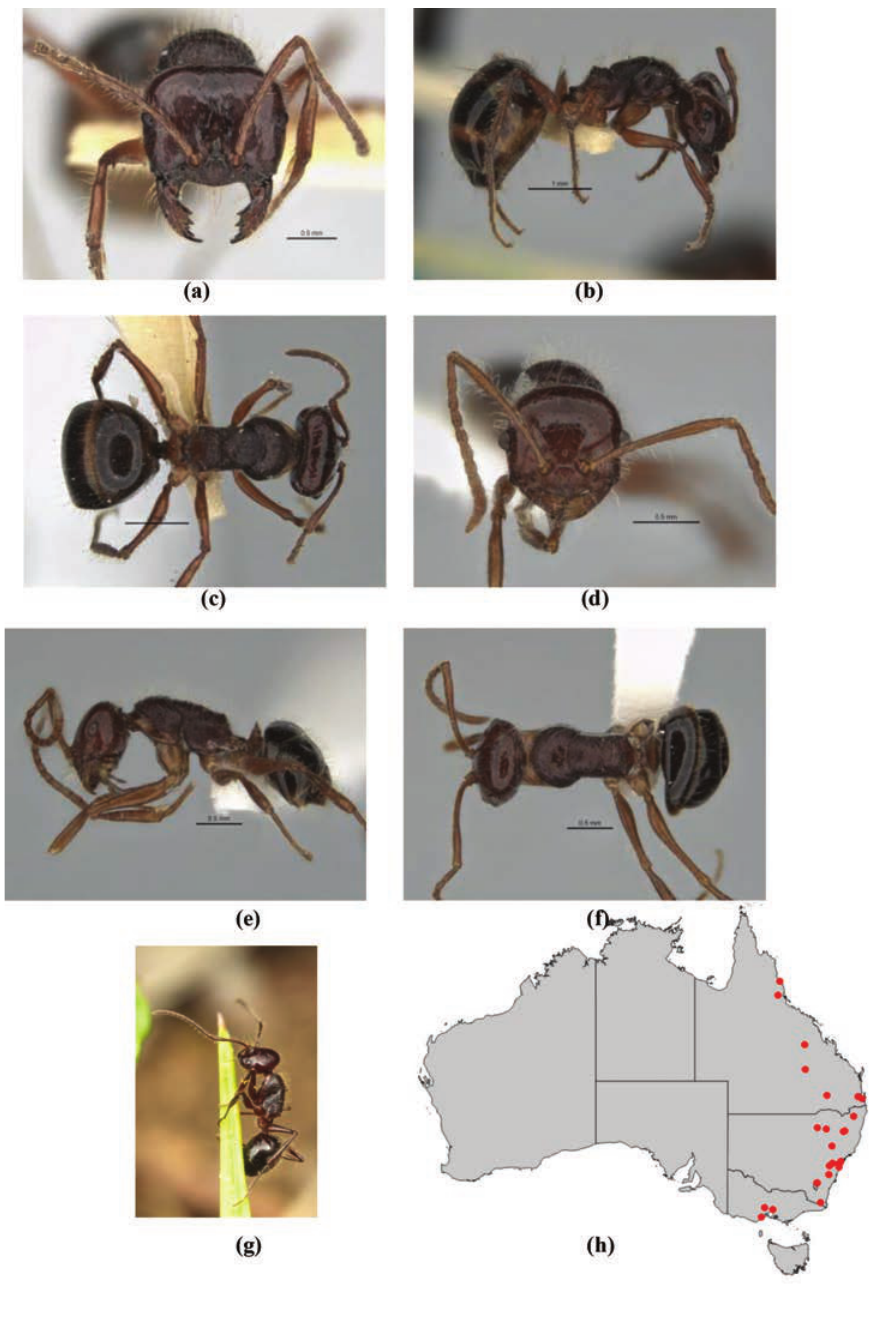
Figure 91. Melophorus hirsutus Forel: major worker (ANIC32-900039) frons ( a ), profile ( b ) and dorsum ( c ); minor worker (ANIC32-900043) frons ( d ), profile ( e ) and dorsum ( f ); M . hirsutus forager on grass stem (photo credit: A. J. Narendra) ( g ); distribution map for the species ( h ). Low resolution scale bars: 1 mm ( b, c ); 0.5 mm ( a, d–f